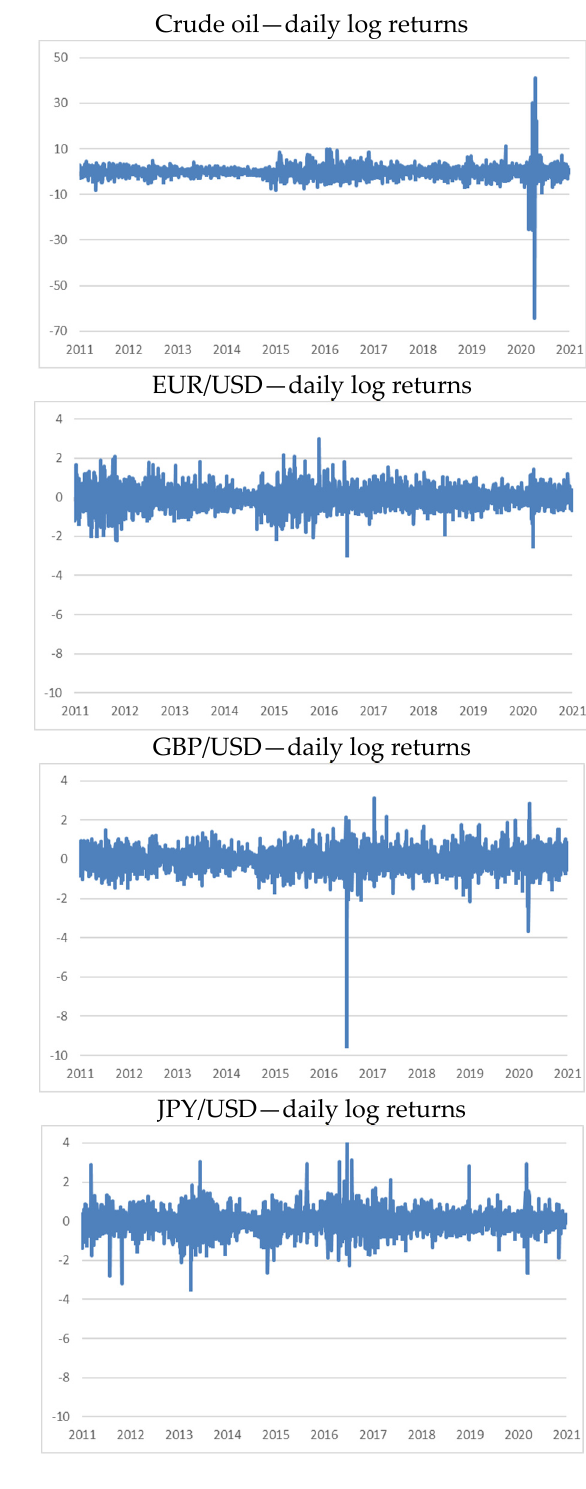
Figure 1. Investigated time series from the period 3 January 2011–31 December 2020. Table 1. Descriptive statistics of the investigated returns.